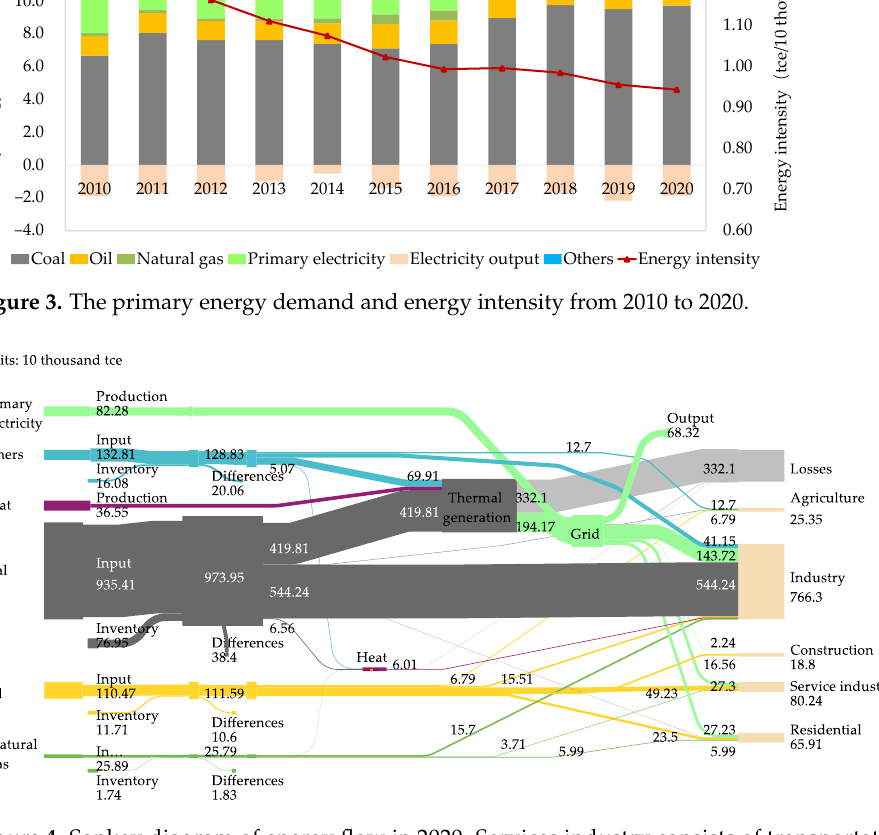
Figure 4. Sankey diagram of energy flow in 2020. Services industry consists of transportation and commercial sectors.